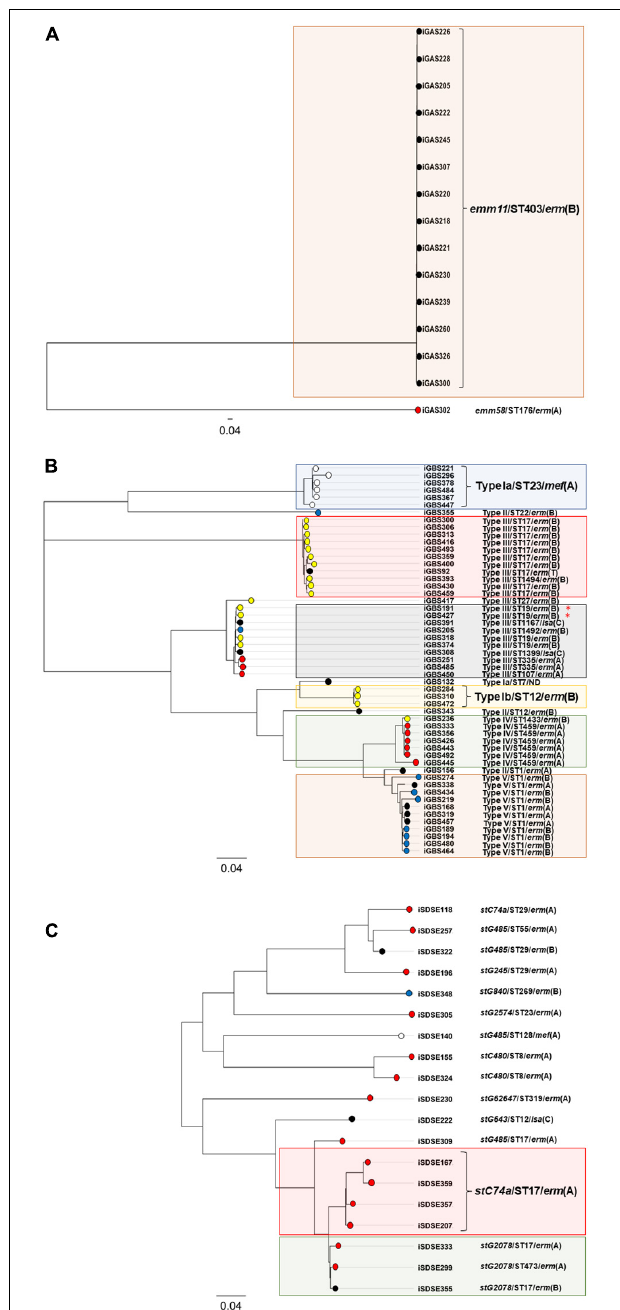
FIGURE 2 | Phylogenetic trees of the resistant BHS – population. The phylogenetic trees are based on core-genome SNP-analysis of S. pyogenes (A) , S. agalactiae (B) , and S. dysgalactiae (C) isolates displaying reduced susceptibility to erythromycin and/or clindamycin. The scale indicates substitutions per site. Isolates clustering with > 97% similarity have been highlighted with colored rectangular boxes. The circular node tips have been assigned color coding according to the mobile genetic element harboring the MLS B -resistance gene in the respective isolates. Red indicates ICE sp2907 , blue color has been assigned to Tn 3872 , yellow indicates ICE Sa2603 , isolates carrying the bacteriophage 1207.3 are white, and all other elements are depicted in black. The red asterisk indicates the two isolates co-harboring lsa